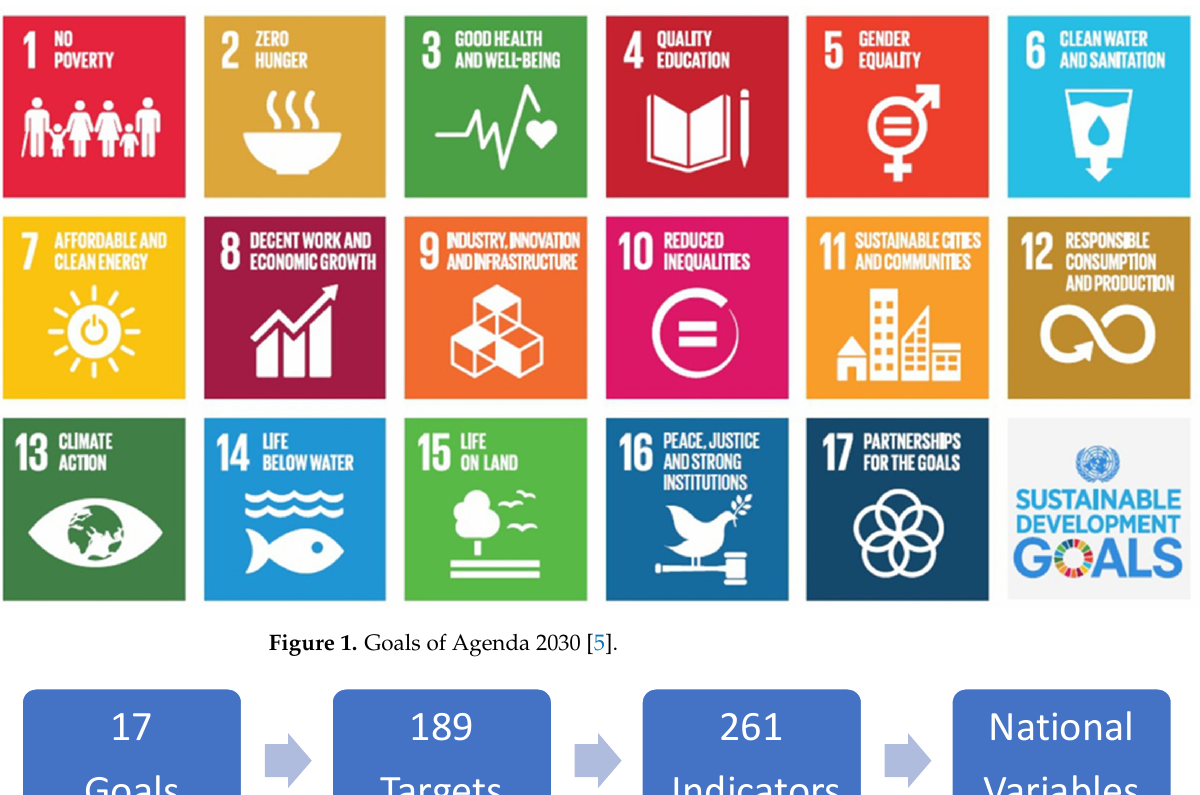
Figure 2. Numerical structure of Agenda 2030.